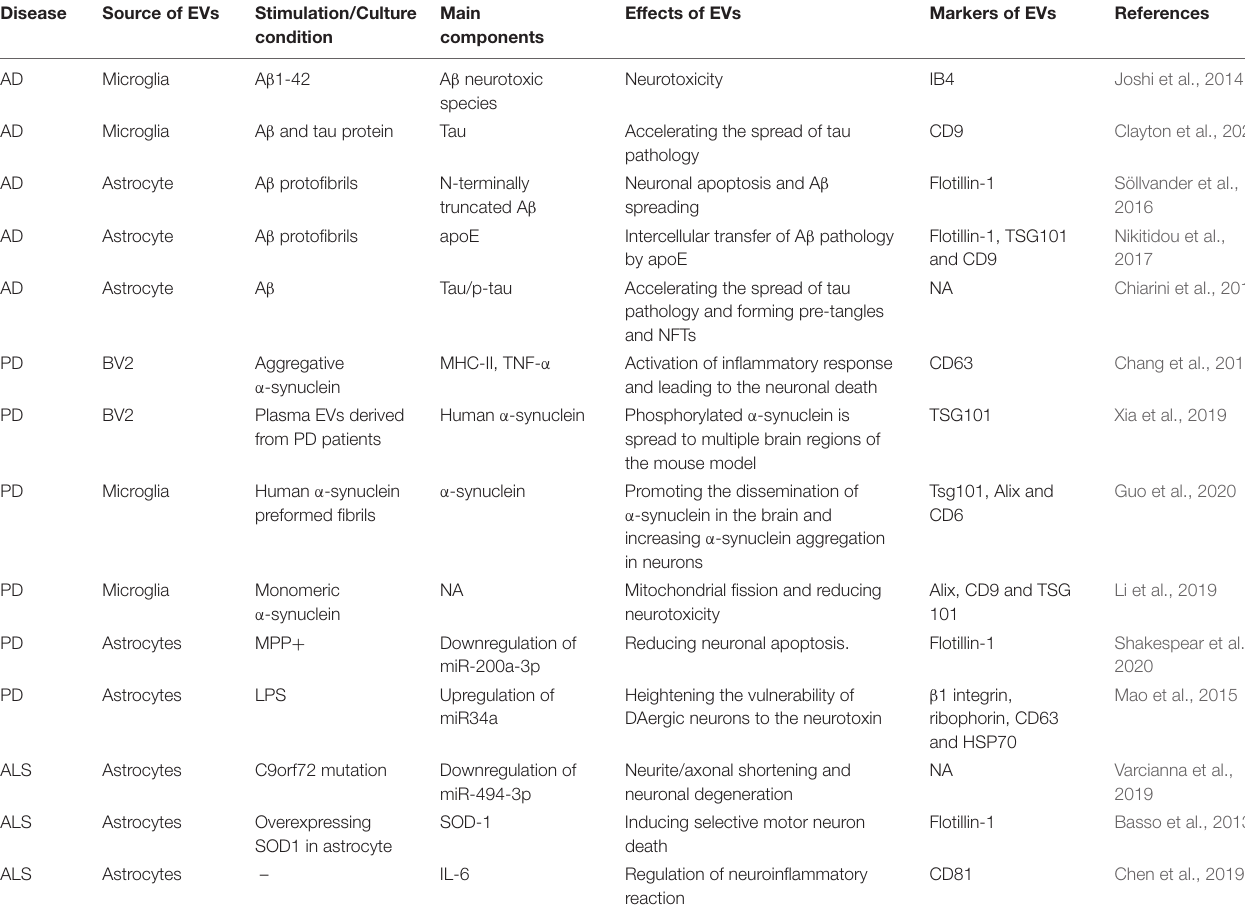
TABLE 1 | Biological properties and effects of glia-derived EVs on neurodegenerative